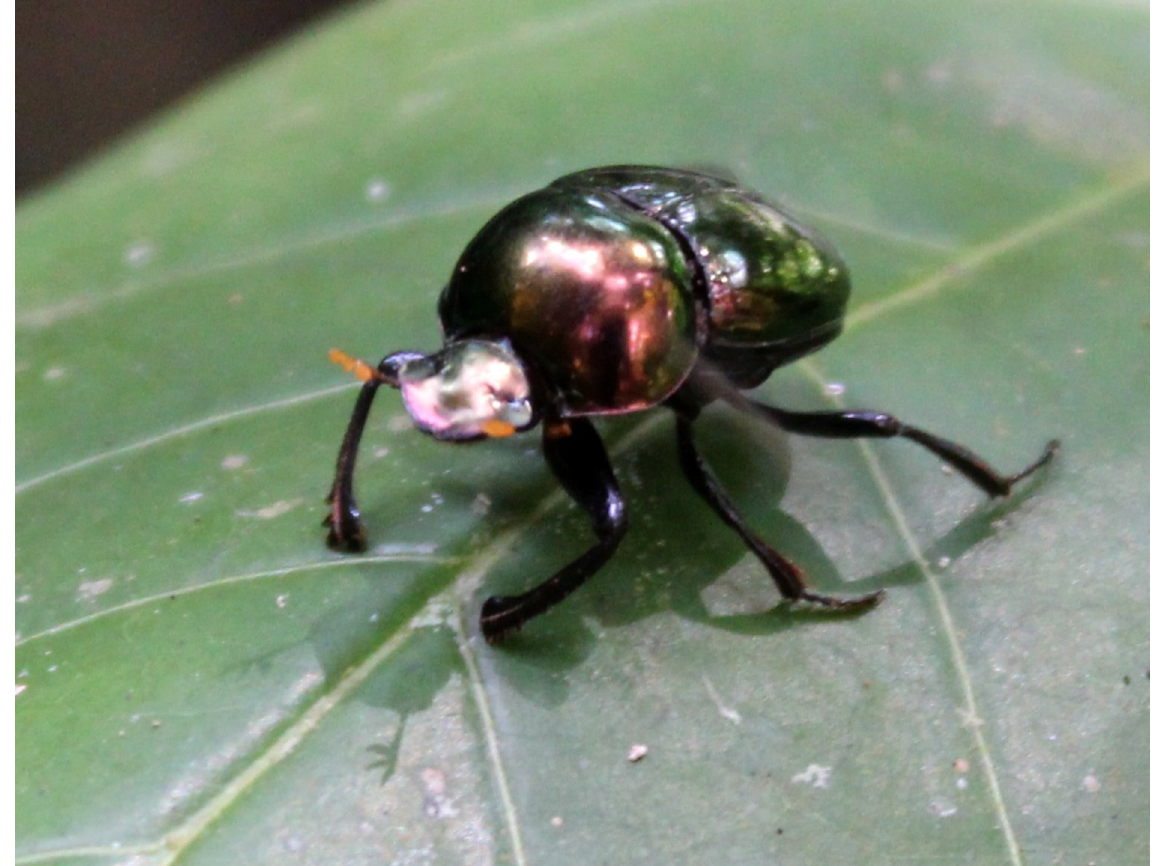
Fig. 10. Canthon (G.) fulgidus fulgidus Redtenbacher, 1868 showing perching